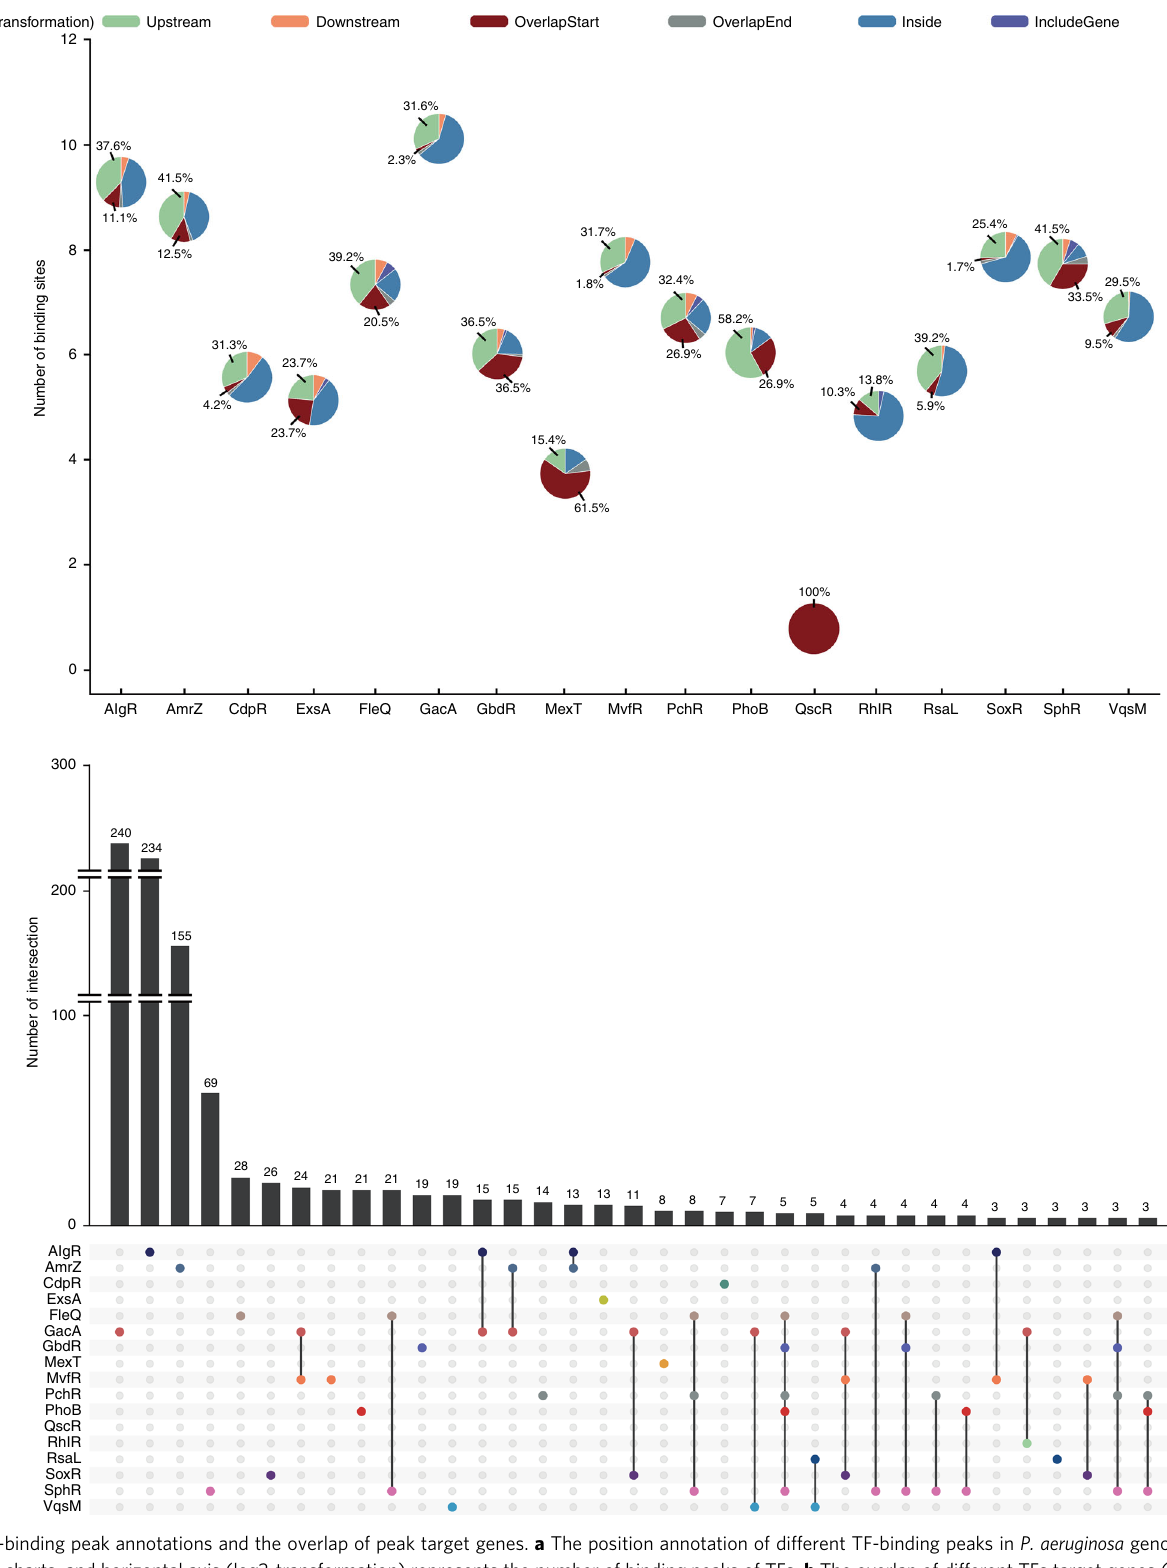
Fig. 1 TF-binding peak annotations and the overlap of peak target genes. a The position annotation of different TF-binding peaks in P. aeruginosa genome using pie charts, and horizontal axis (log2-transformation) represents the number of binding peaks of TFs. b The overlap of different TFs target genes (TF- binding peaks located on promoters of genes), the histogram represents the number of genes in individual/overlapped